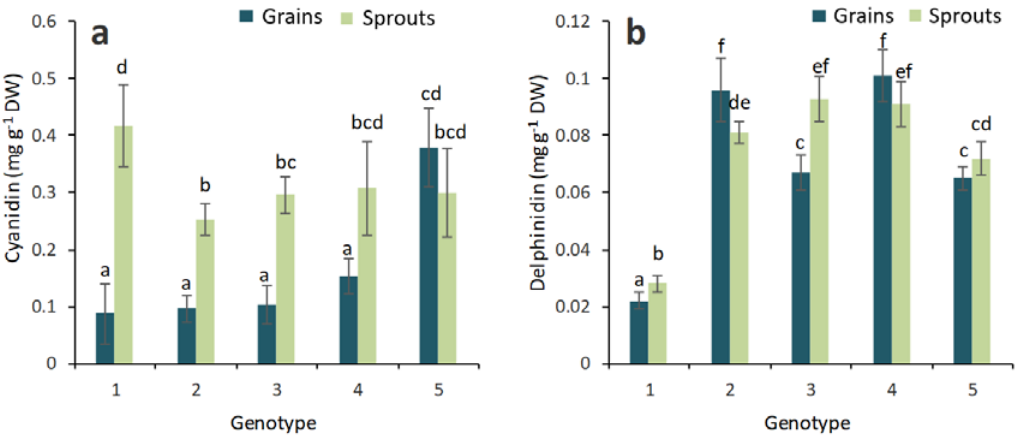
Figure 5. Cyanidin ( a ) and delphinidin ( b ) in the grains and sprouts of colored wheat genotypes. The columns represent the mean values ± S.E. for five replicates. 1—Citrus yellow, 2—KM 53-14 Blue, 3—KM 178-14 purple, 4—Skorpion Blue aleurone, 5—PS Karkulka purple. Statistically significant differences among treatments at each time are indicated by different lowercase letters (Duncan test; p < 0.05).